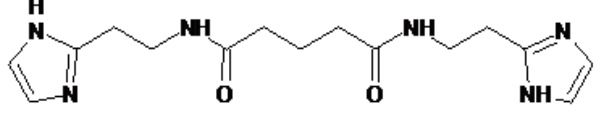
Figure 5. Structural formula of pharmacological compound Treamid, synonym bisamide derivative of dicarboxylic acid, chemical formula N1, N5-bis [2-(1H-imidazole-2-Il)ethyl] glutaramide.